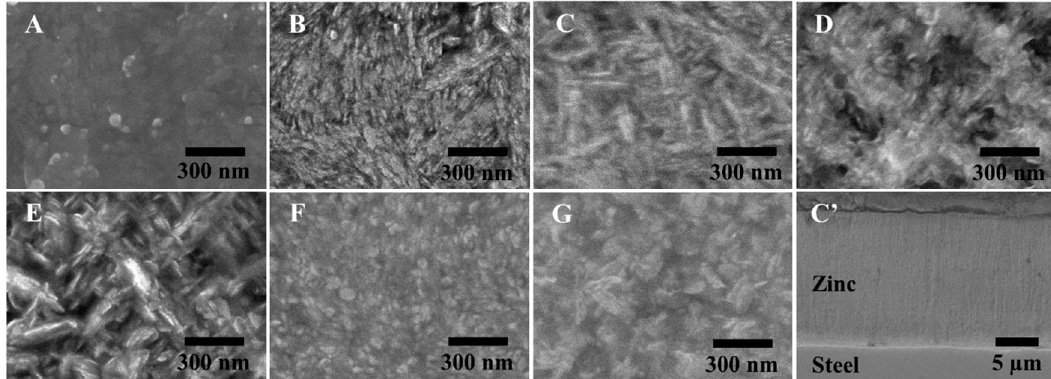
Figure 2. Scanning electron micrographs of electroplated zinc surface with different Zn/NaOH ratios: ( A ) 0.042, ( B ) 0.067, ( C ) 0.092, ( D ) 0.117, ( E ) 0.122, ( F ) 0.073, ( G ) 0.061, and ( C’ ) a representative cross-sectional view of the coating prepared from bath C.